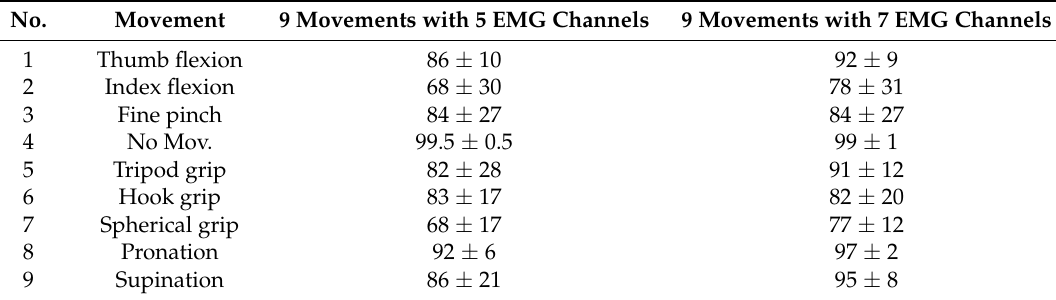
Table 6. Overall average classification accuracies for each movement-class in percent (and their respective standard deviation for nine amputees), for the case of 9 movements with 5 EMG channels and for the case of 9 movements with 7 EMG channels with TD-PSD and the proposed adaptive windowing